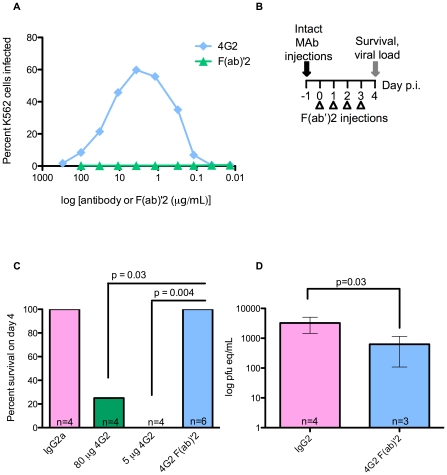
Antibodies that lack the Fc region fail to mediate ADE and instead protect against lethal challenge.
A. Infection of K562 cells by DV2 in the presence of 4G2 mAb or 4G2 F(ab′)2 fragment was determined 48 hours post-infection by staining with Alexa488 anti-DV E protein MAb followed by flow cytometry. Average infection without antibody was 0.74%. B. Dosing scheme used to compare the in vivo effects of F(ab′)2 and intact mAb. Mice were administered intact 4G2 or IgG2a control mAb on day −1, or 20 µg doses of F(ab′)2 every 24 hours beginning 1 hour prior to infection, and were then challenged with 105 pfu of DV2 iv. C. Survival in mice from (B) receiving the indicated antibodies was scored on day 4 post-infection, and a two-sided Fisher's exact test was used. D. Viremia at day 4 post-infection in surviving mice from (C), measured by qRT-PCR. Error bars represent standard deviations, and pairwise comparisons were performed by two-sided Wilcoxon rank sum tests.